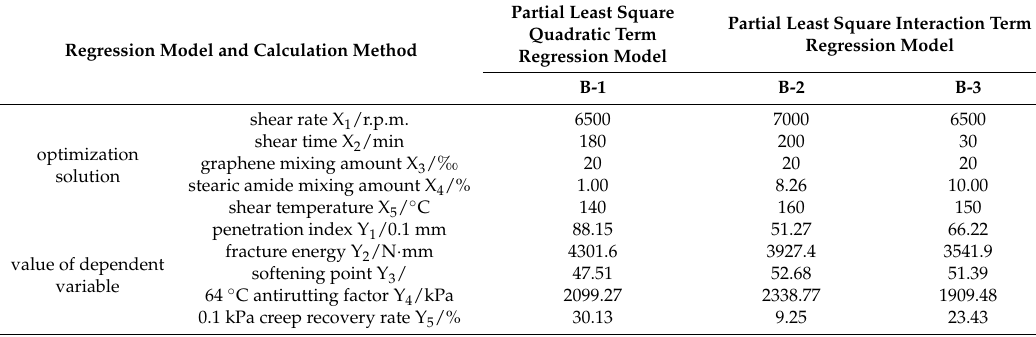
Table 8. Optimization solution and corresponding dependent variable in each regression model.